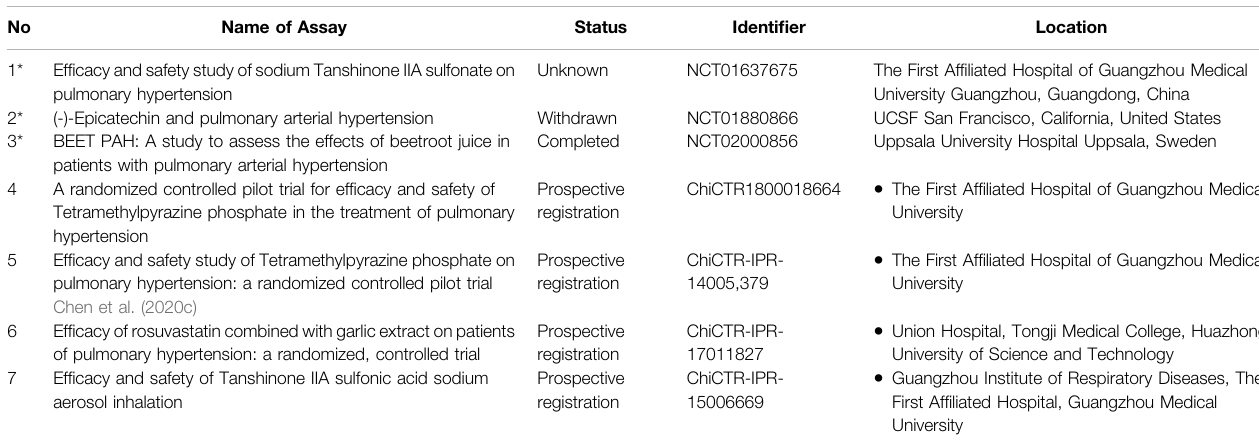
TABLE 1 | Current FDA and CFDA Clinical Trials for PAH involving THM components.